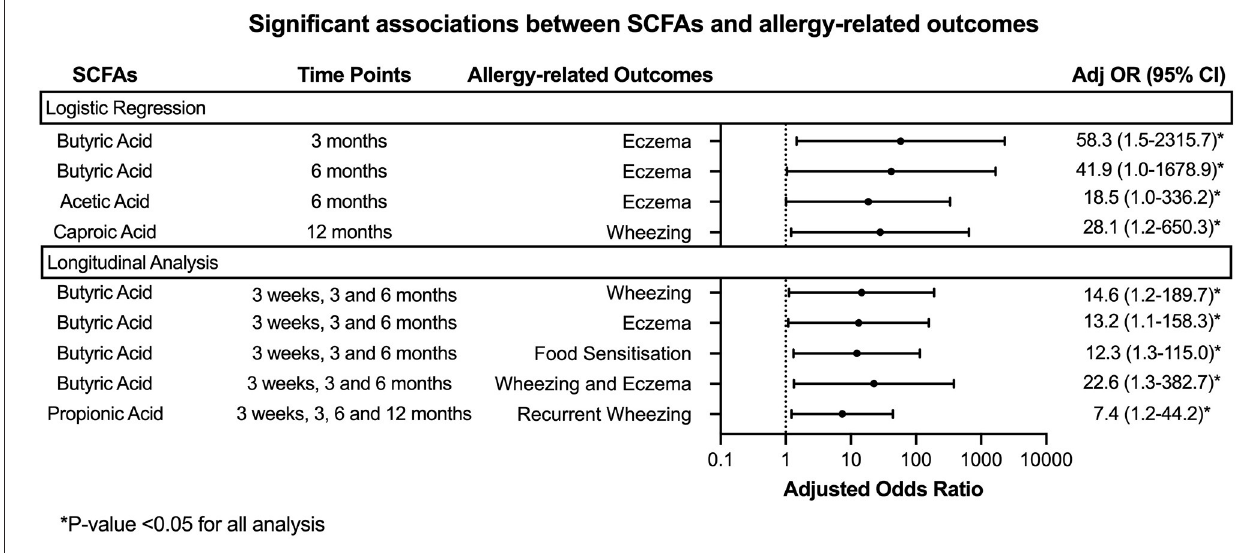
Frontiers in Allergy |